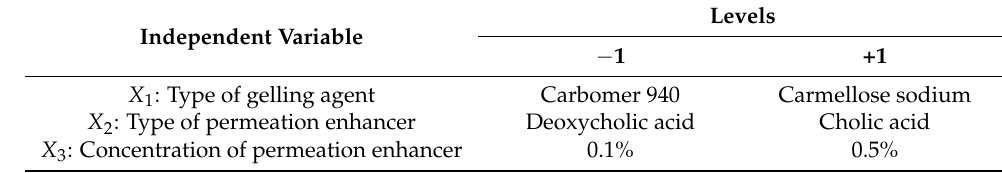
Table 5. Factors and levels for 2 3 factorial design.